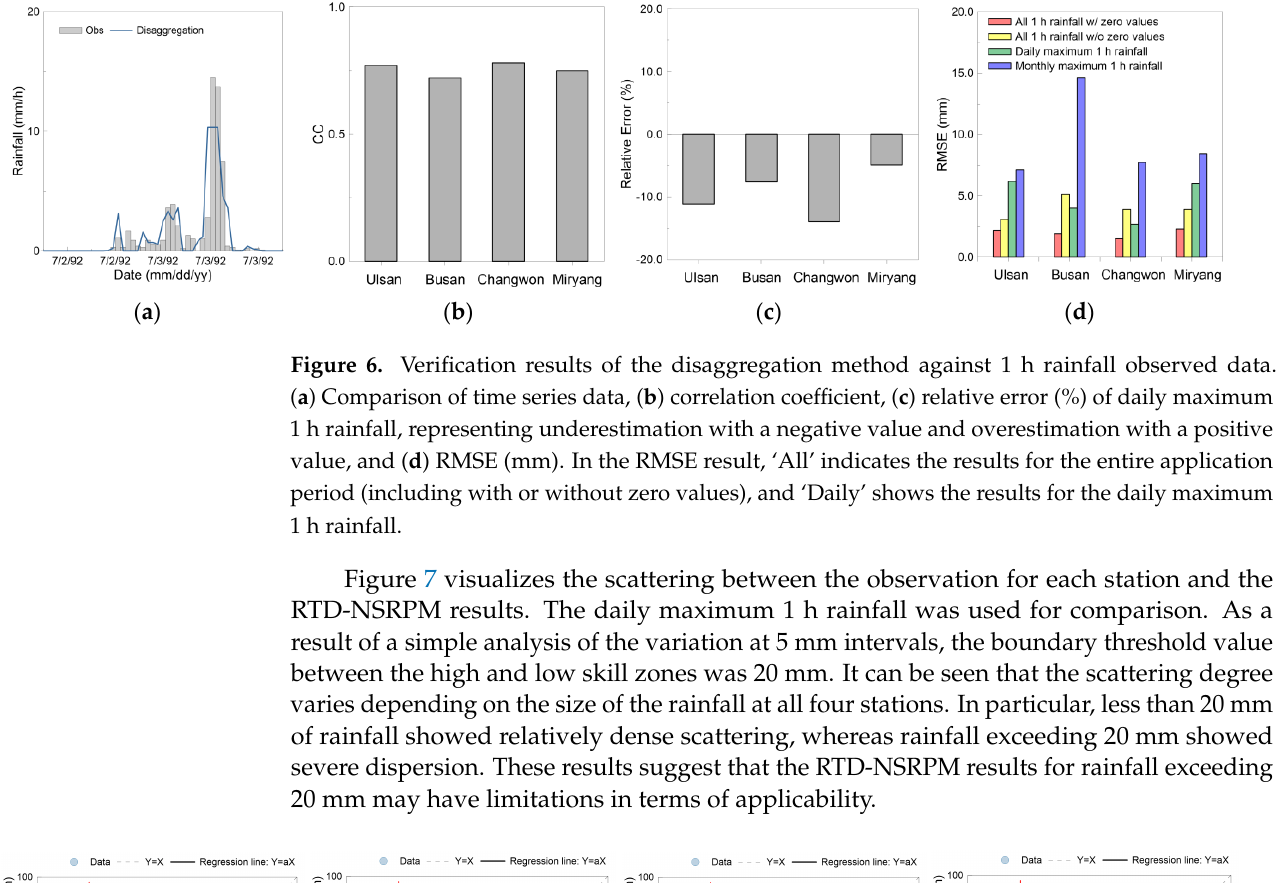
( d ) Figure 8. Comparison of T-year recurrence interval (2~200 years) rainfalls from the observed (black), NSRPM (Red), and disaggregation (Blue) rainfalls. ( a ) Ulsan, ( b ) Busan, ( c ) Changwon, and ( d ) Miryang. Next, the results of the two methods for the RCM data were reviewed. Figure 9 shows the estimation results for the rainfall quantiles (for 2, 5, 10, 20, 50, 100, and 200 years) by the RCM for the present period. Eight RCM data were equally applied to both methods, and performance was verified by comparing the ranges of the rainfall quantile for each recurrence interval. The most significant difference in the rainfall quantile for each recur- rence interval for the two methods is the maximum–minimum range of the eight RCM results. The NSRPM results showed reasonably high variability depending on the RCM, whereas the disaggregation method (RTD-NSRPM) showed a relatively stable range of